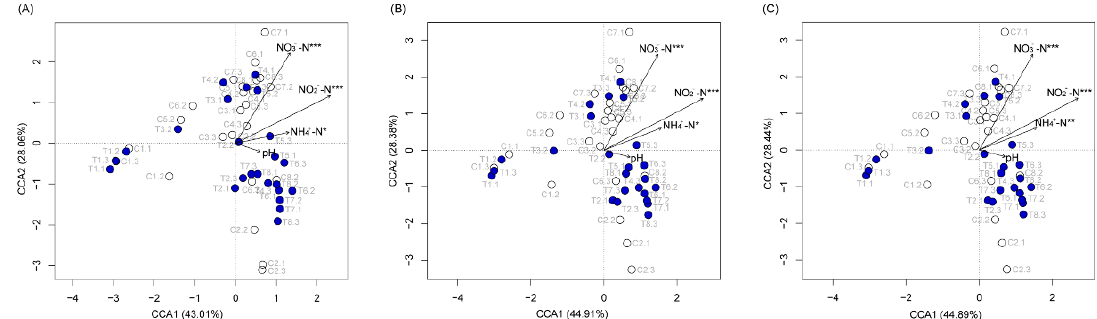
Figure 4. Canonical correspondence analysis profiles based on OTUs ( A ), genera ( B ), and dominant genera ( C ) compositions of water microbiota and on aquatic environmental factors. Dark blue circles indicate samples treated with Pseudomonas furukawaii ZS1. White circles indicate samples of control. *, p < 0.05; **, p < 0.01; ***, p < 0.001.